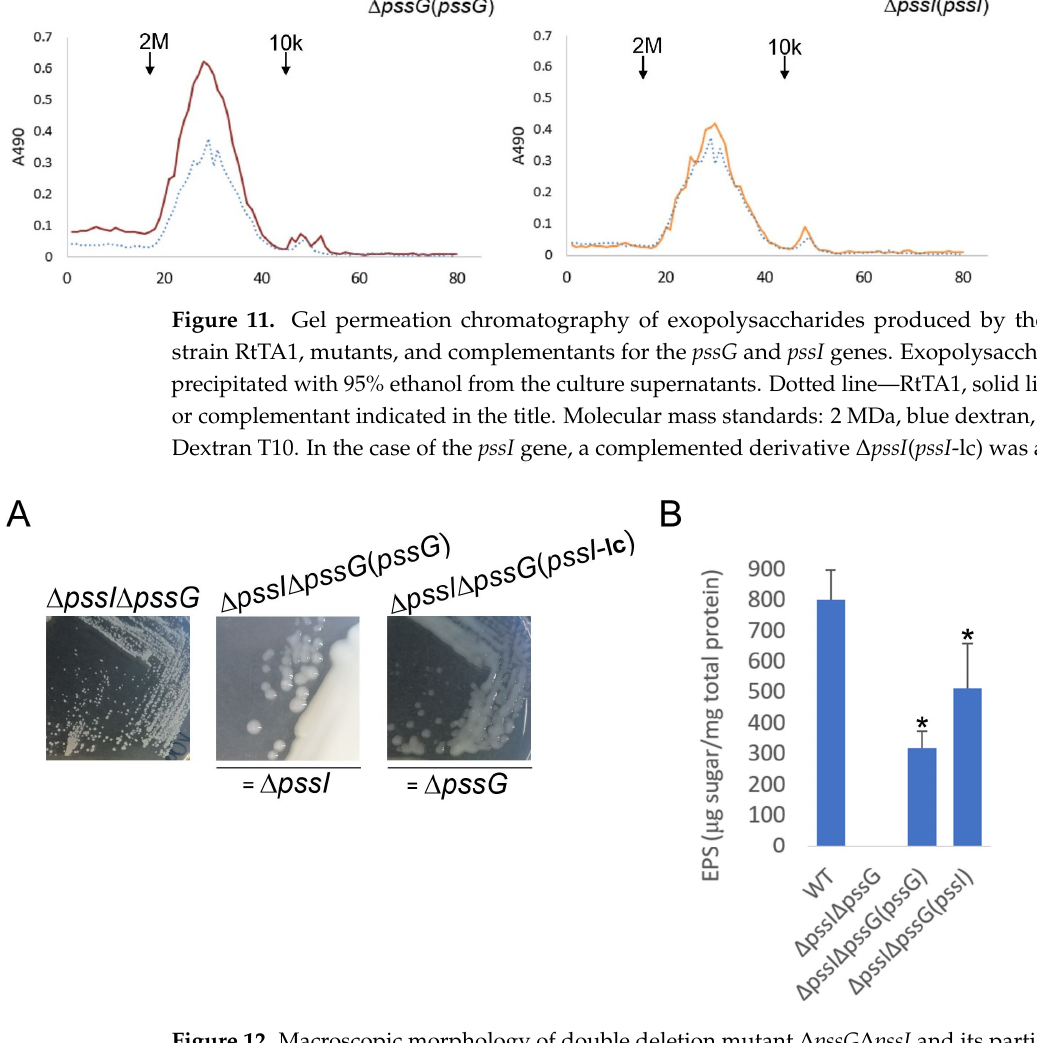
Figure 12. Macroscopic morphology of double deletion mutant ∆ pssG ∆ pssI and its partially complemented variants, with either pssG or pssI gene introduced. The same complementation plasmids, based either on pBBRMCS-2 or pRK7813, were used, as previously. In genetic terms, ∆ pssG ∆ pssI ( pssG ) corresponds to ∆ pssI and ∆ pssG ∆ pssI ( pssI ) corresponds to ∆ pssG ( A ). The result of EPS quantification in liquid culture supernatants is shown in ( B ). Bars represent the mean values of four independent experiments with two technical repeats each. Error bars represent standard deviation. Asterisks (*) mark bars representing amounts significantly different than produced by the WT strain ( p < 0.01). The photographs in ( A ) were taken 5 days post ‐ inoculation.